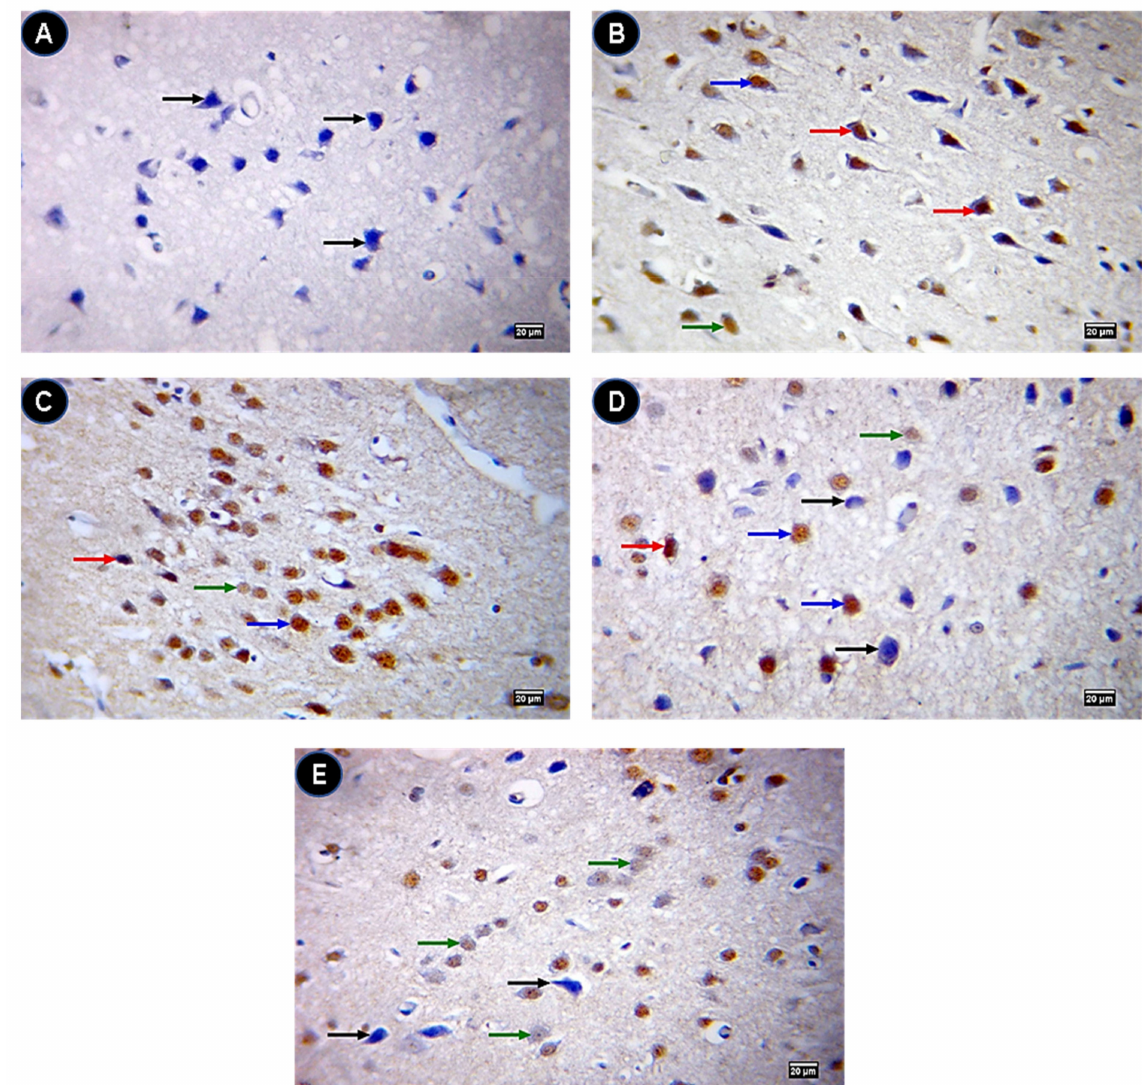
Figure 8. Immunohistochemistry of caspase 3 in brain tissue. ( A ) Control group showing a caspase 3 negative (black arrow) immunostained neuron. ( B ) IONPs group showing strong (red arrows), moderate (blue arrow) and weak (green arrow) caspase 3 positive brown immunostained neurons. ( C ) IONPs + Q25 group showing strong (red arrow), moderate (blue arrow) and weak (green arrow) caspase 3 positive brown immunostained neurons. ( D ) IONPs + Q50 group showing strong (red arrow), moderate (blue arrows) and weak (green arrow) caspase 3 positive brown immunostained neurons. ( E ) IONPs + Q100 group showing negative (black arrows) and weak (green arrow) caspase 3 positive brown immunostained neurons. × 400. Scale bar = 20 µ